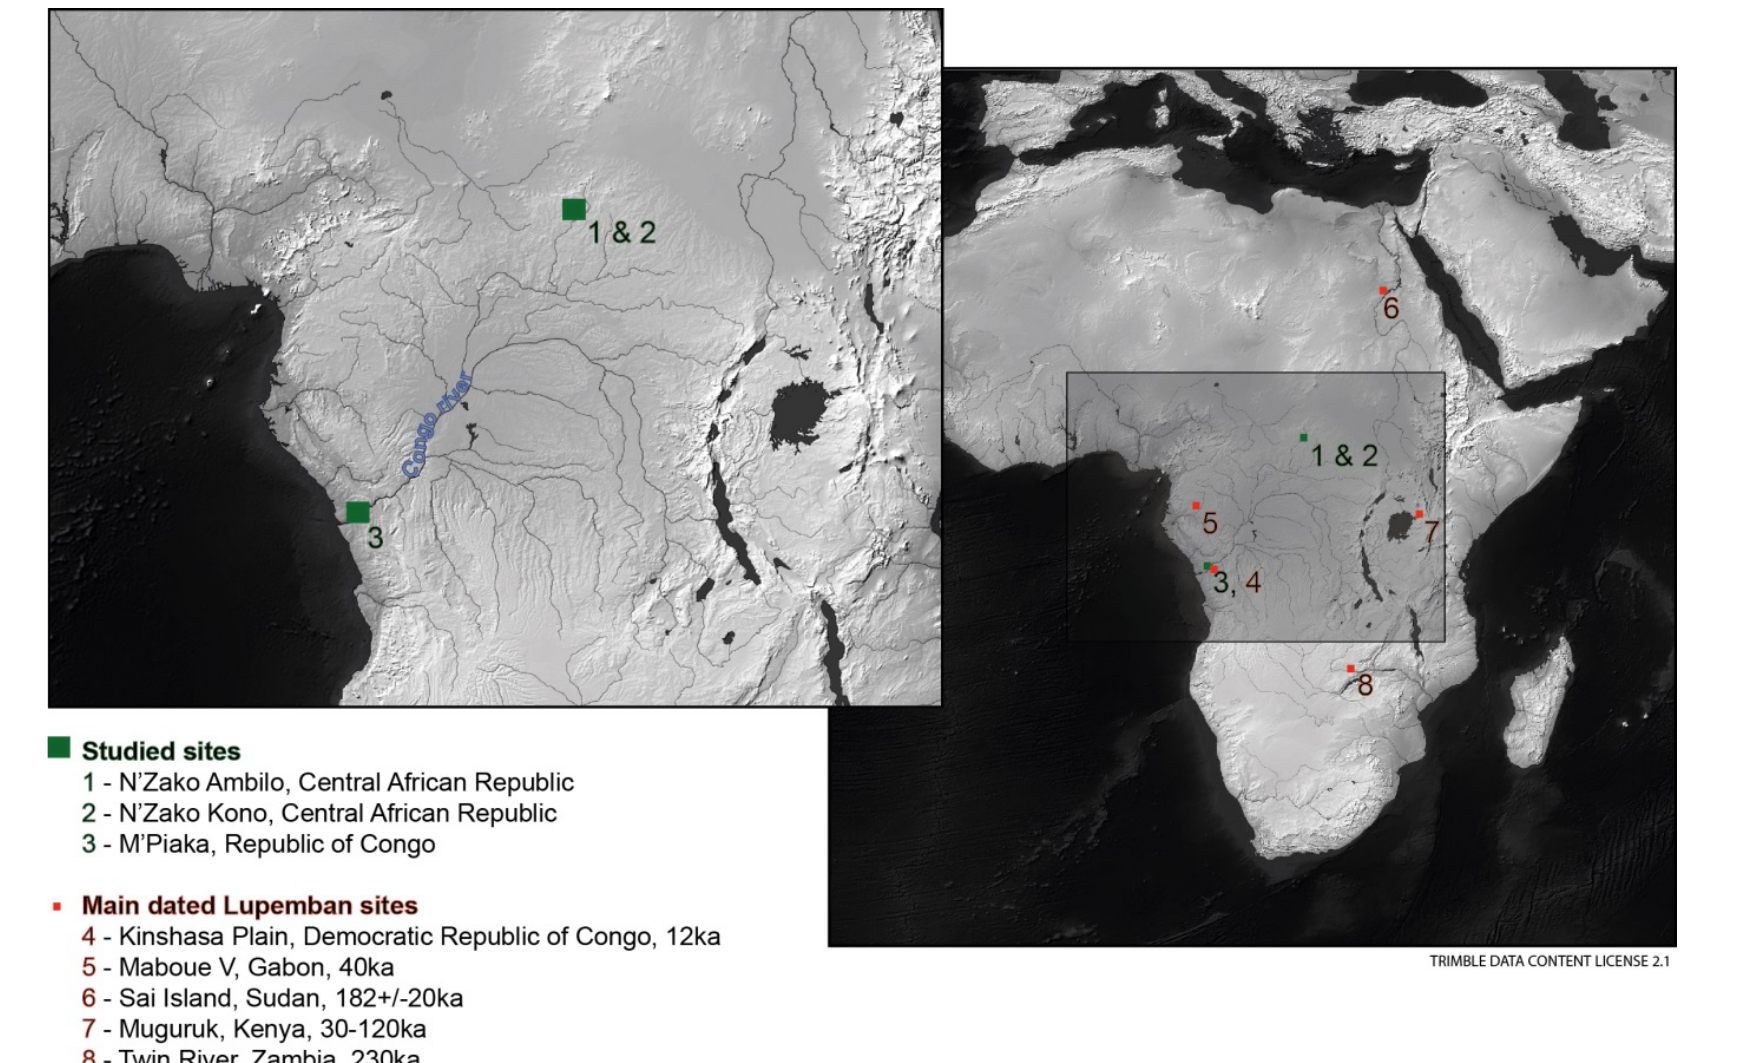
Figure 2. Map of the studied area and location of studied sites and main dated sites within the Congo Basin and its